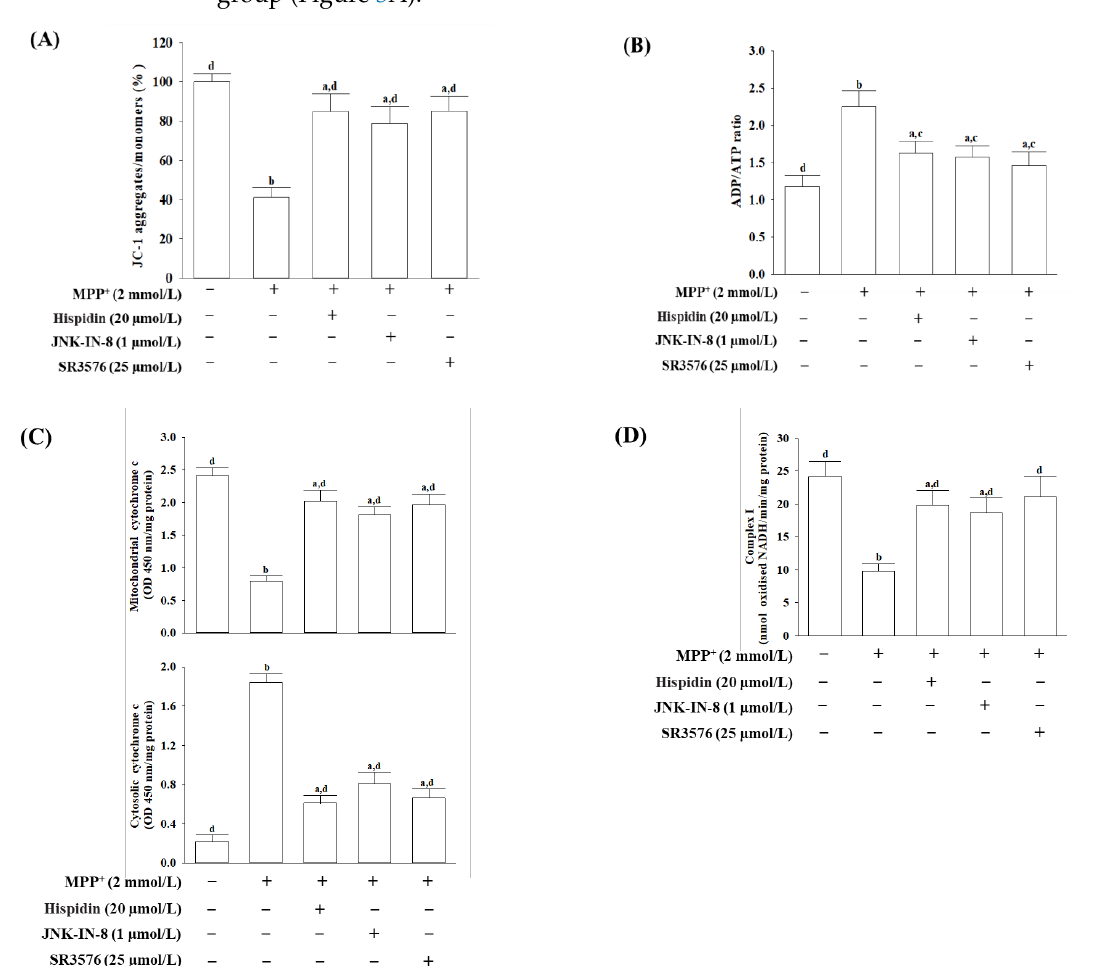
8 of 16 Figure 2. Hispidin protects MES23.5 cells against MPP + - activated oxidative stress. MES23.5 cells